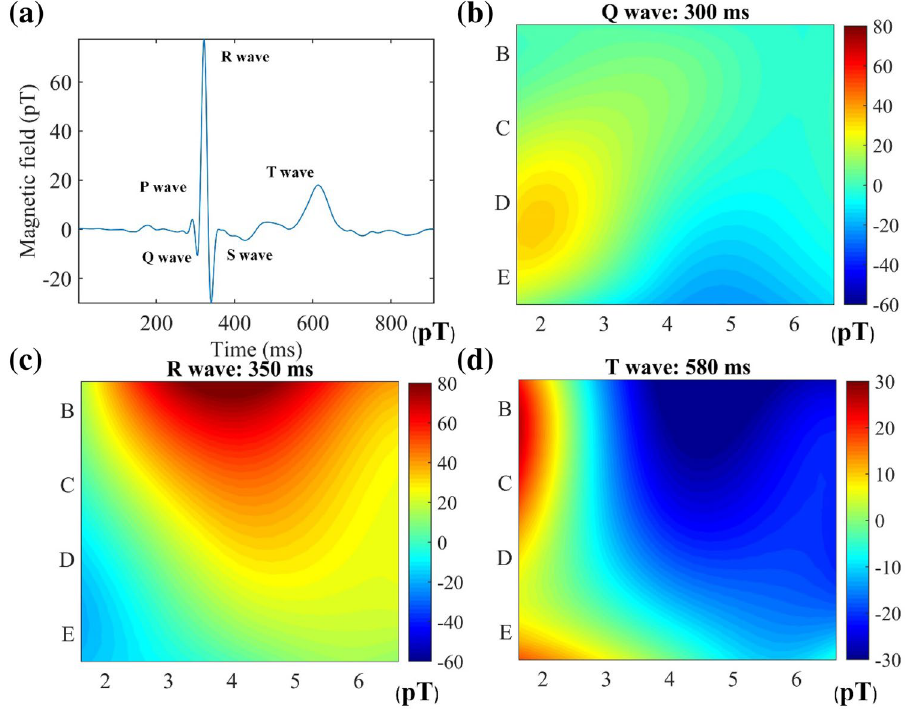
Figure 8. ( a ) MCG signal at D2. The MCG signal has the characteristics of a P wave, QRS wave and T wave group. Twenty-channel MFMs of the ( b ) Q peak, ( c ) R peak and ( d ) T peak. The Y axis and X axis coordinates correspond to the position of the sensor, as shown in Fig. 1. Normal MFM has a single dipole structure. The color depth of the figure represents the intensity of the magnetic field, corresponding to the color bar in the